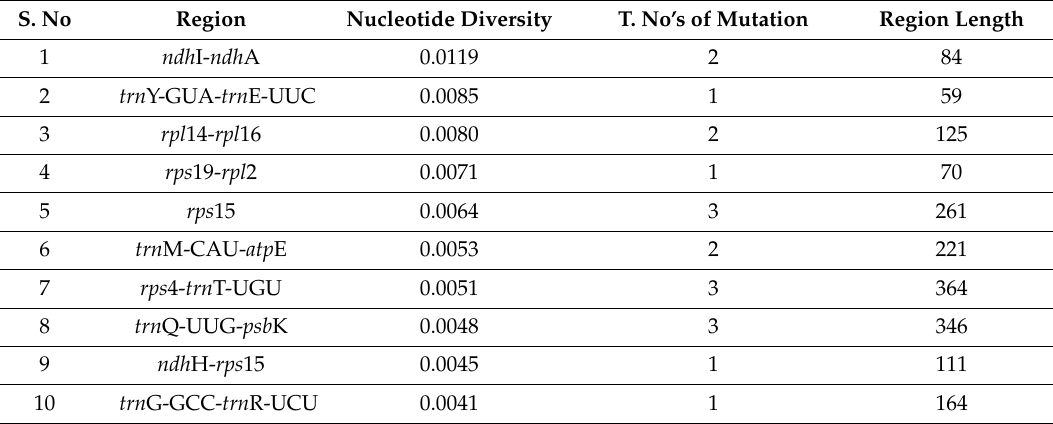
indel diversity are shown with a 100 bp window size. Table 5. Mutational hotspots among Withania